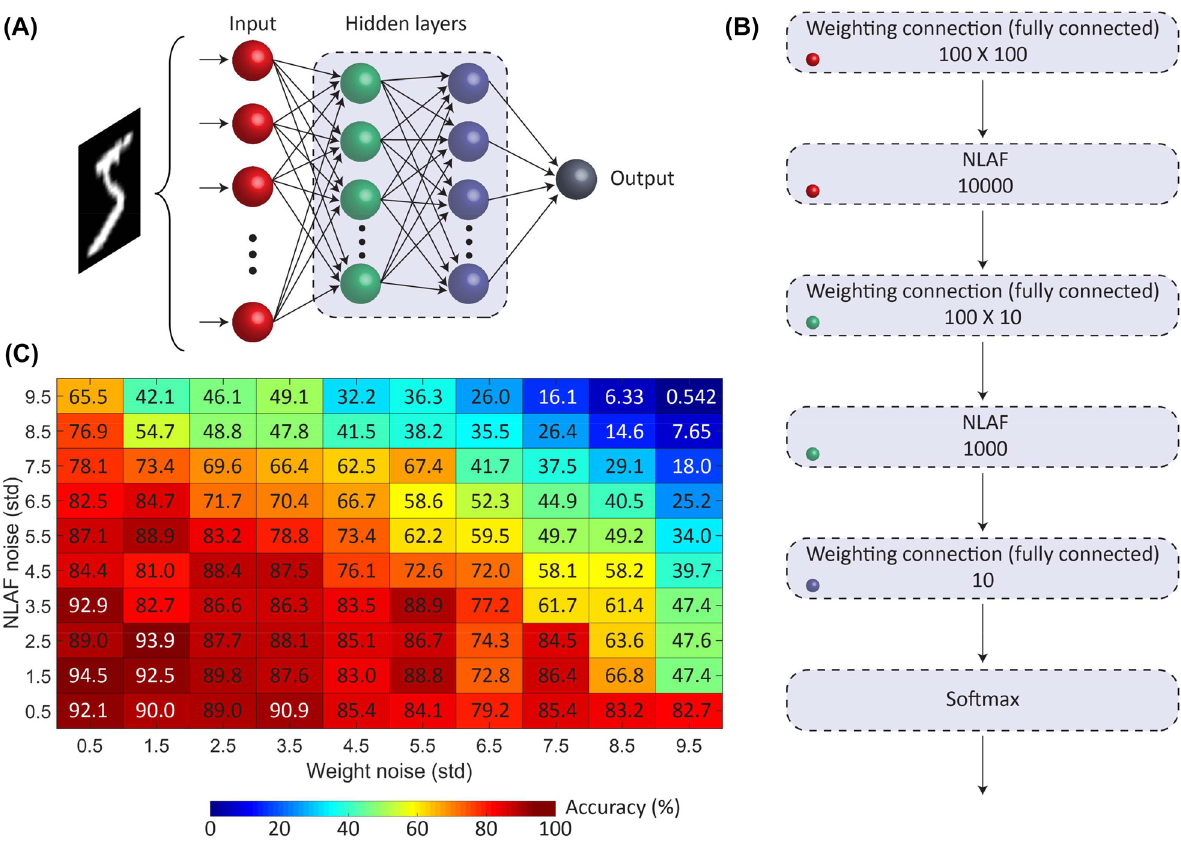
Figure7: Chalcogenide-tunedneuralnetworkusedtorunMNISTdataset.(A)Schematicoftheneuralnetwork.(B)Neuralnetworkcomponents in each neural layer. The colored circles represent the corresponding neural layers found in (A). (C) Corresponding network accuracy for the different switching errors in the weights and